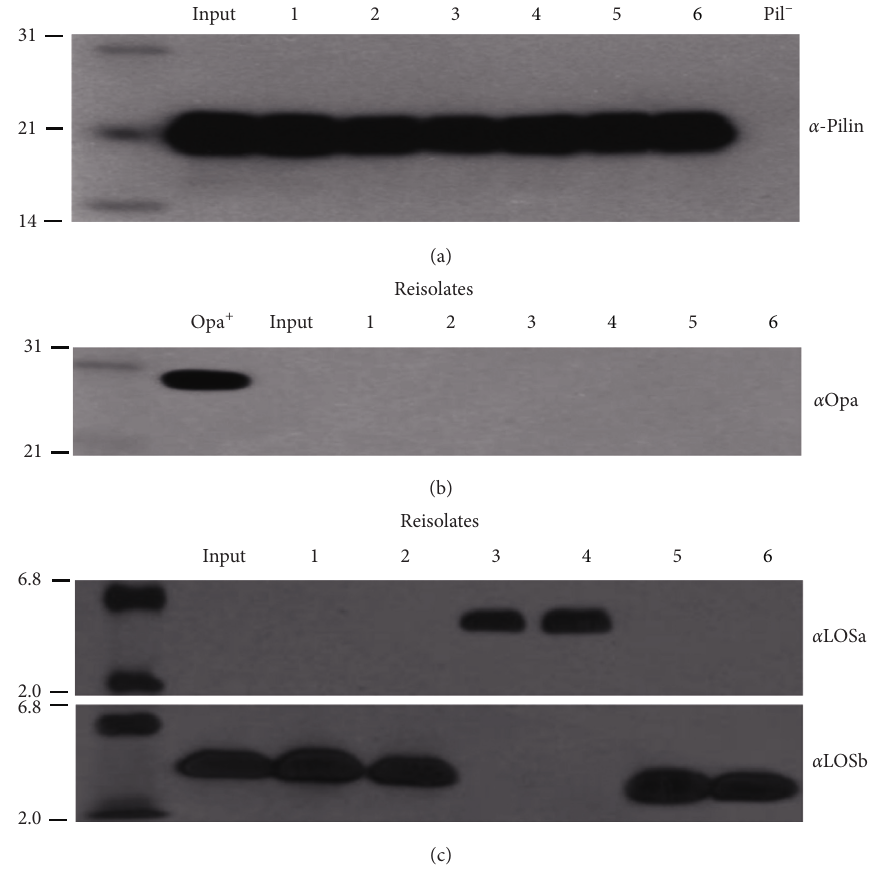
Figure 1: Analysis of the pili, Opa protein, and LOS phenotypes of reisolates. (a) Whole cell lysates of reisolates were subjected to SDS- PAGE and were immunoblotted with anti-pilus monoclonal antibody MCO2. (b) The expression of the Opa protein was detected with monoclonal antibody 4B12, which reacts with all of the Opa proteins expressed by the strain MS11mk. (c) The LOS preparations were analyzed by SDS-PAGE and then immunoblotting with α LOSa and α LOSb. Autoradiography was used to detect the LOS labelled in vitro. Lanes 1 to 6 represent G29, 4R1, SA, 7uB, 6uF, and V3, respectively. The molecular mass markers (in kilodaltons) are indicated on the left side of the panels.